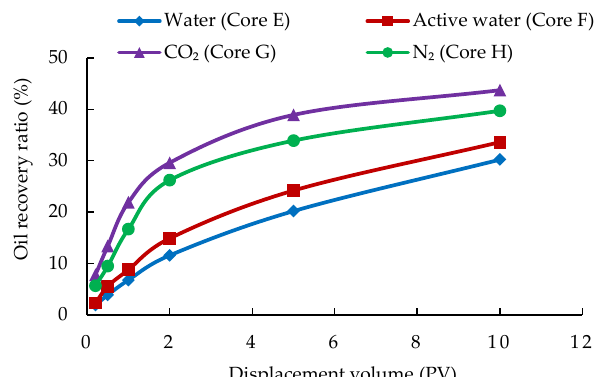
Figure 5. Oil recovery ratio of four cores under different injection media.